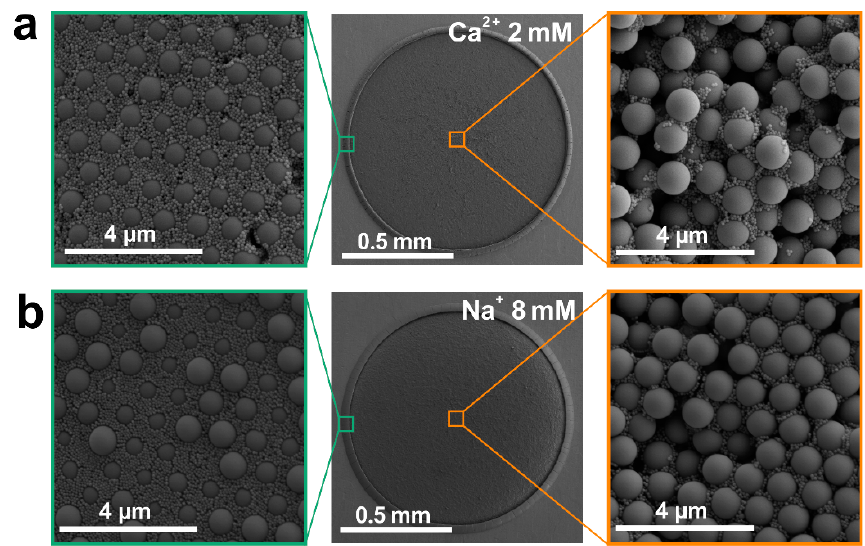
Figure 3. SEM images of the deposit patterns dried from suspensions containing bi-dispersed F-PS particles (1.0 μ m and 0.1 μ m in diameters) and different salts on graphene: ( a ) CaCl 2 at 2.0 mM; ( b ) NaCl at 8.0 mM. The left and right show zoomed-in SEM images of selected areas at the rim and center, respectively.